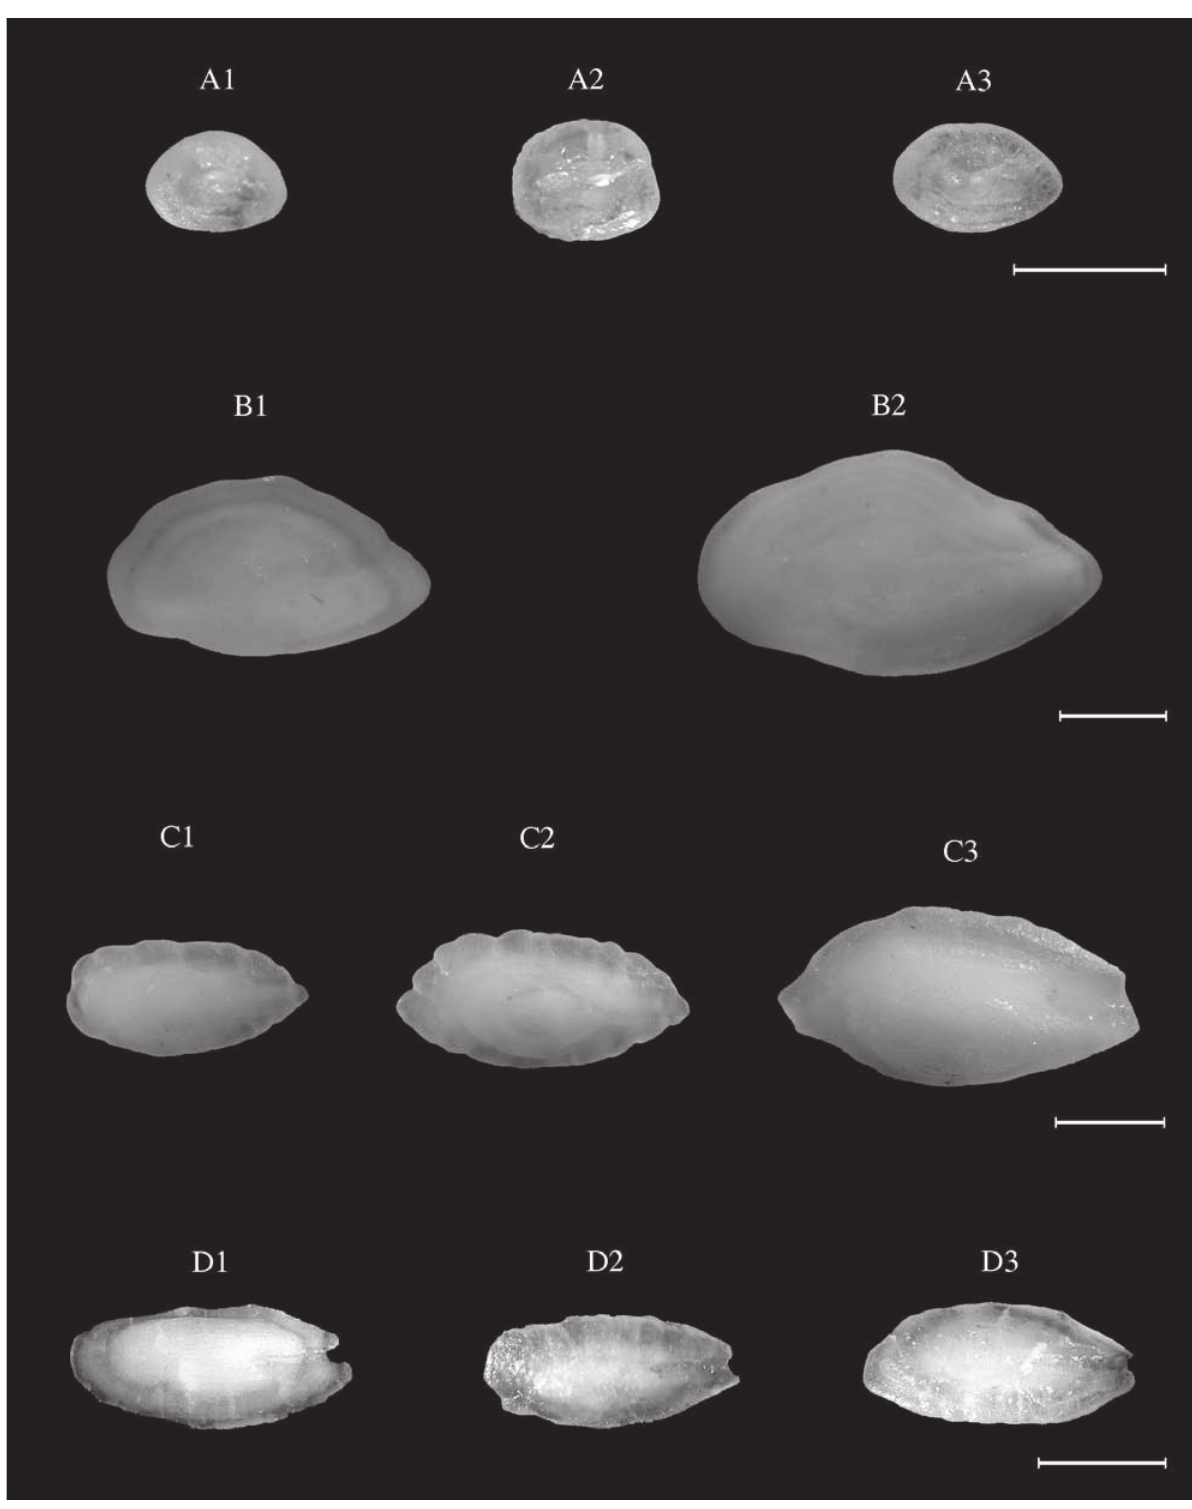
Fig. 73. – Melanostigma atlanticum (WM). TL: A1, 8.0 cm; A2, 9.5 cm; A3, 11.0 cm. Chiasmodon niger (CEA). TL: B1, 16.0 cm; B2, 20.5 cm. Ammodytes tobianus (NEA) . TL: C1, 10.5 cm; C2, 12.7 cm; C3, 15.7 cm. Gymnammodytes cicerelus (WM) . TL: D1, 11.5 cm; D2, 12.0 cm; D3, 12.5 cm. Scale bar = 1